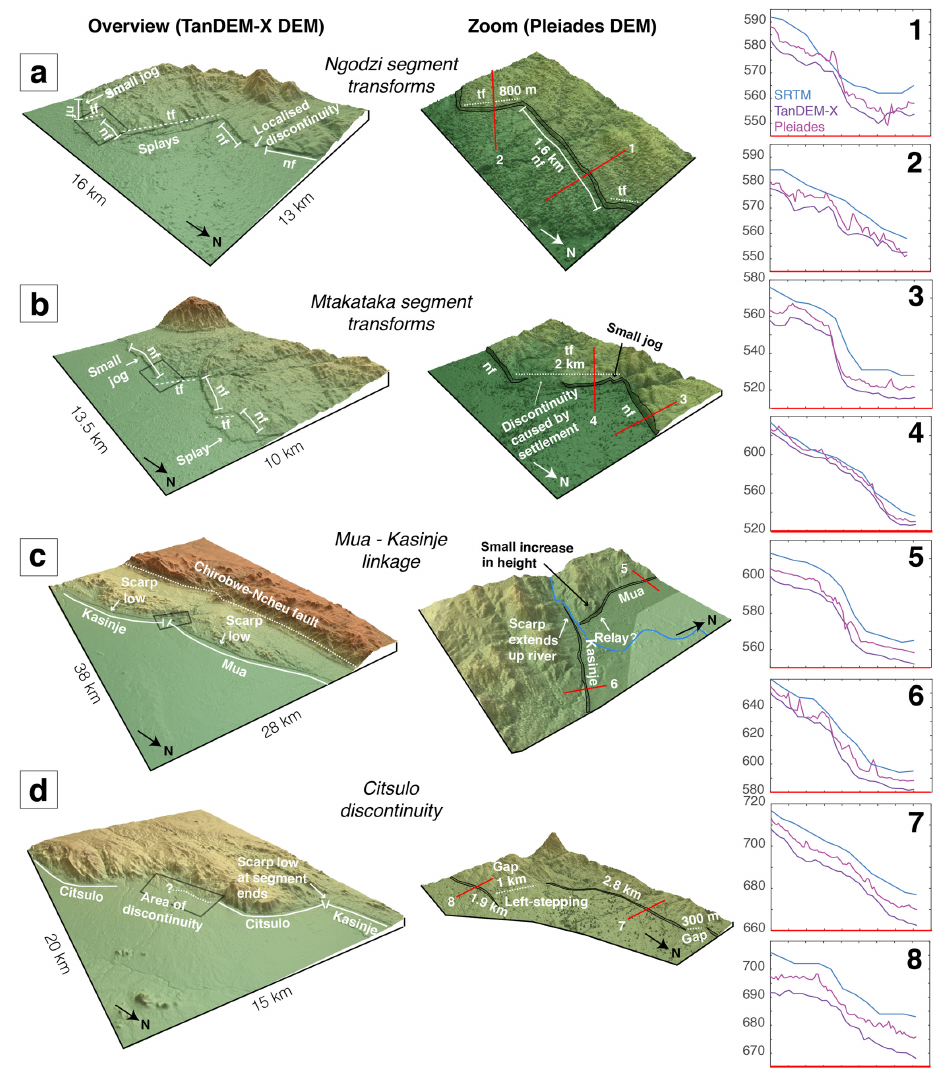
Figure 11. Oblique perspective images taken from the TanDEM-X and Pleiades DEMs for the Bilila–Mtakataka fault. (a) Ngodzi segment normal (nf) and transfer faults (tf) trend in a zig-zag pattern. (b) Mtakataka segment normal and transfer faults. (c) Mua and Kasinje segments intersecting at the Livelezi River. A small increase in scarp height on the Mua segment may relate to a relay ramp linkage. (d) The Citsulo segment and area of discontinuity. Small, north-striking, left-stepping faults are offset by up to 1km. Example profiles for SRTM, TanDEM-X and Pleiades DEMs are also